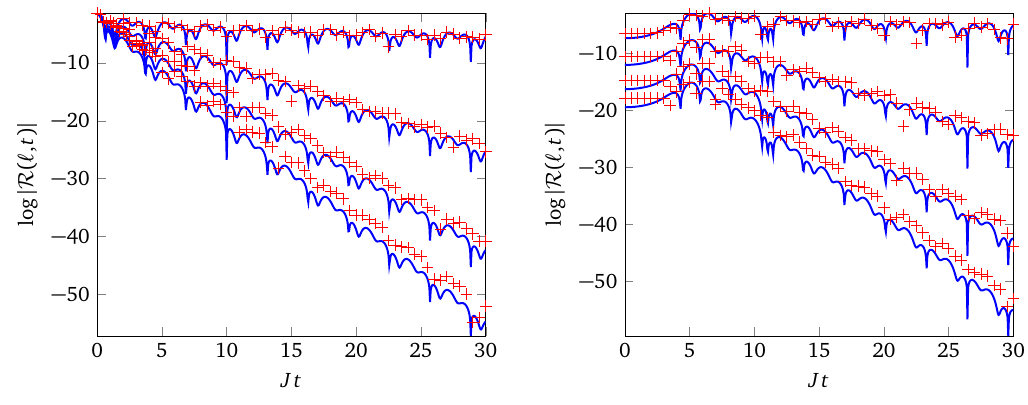
Figure 16: log | R ( (cid:96) , t ) | as a function of t for h = 1.5 and β = 2,0.5,0.286,0.2 from top to bottom inside each panel, with (cid:96) = 0 (left) and (cid:96) = 10 (right). Numerical results for a L = 200 site open chain are shown as red crosses and equation (150) as a solid blue